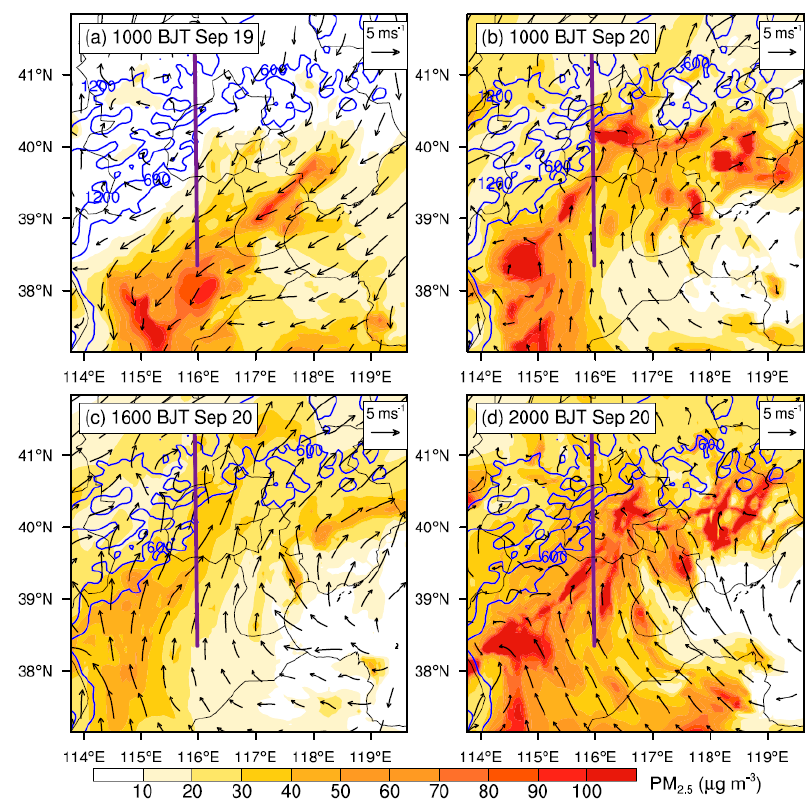
Figure 8. Spatial distributions of simulated near-surface PM 2.5 concentration at ( a ) 10:00 h BJT on 19 September, and ( b – d ) 10:00, 16:00, and 20:00 h BJT on 20 September, overlaid with 10-m wind vector fields. The blue contour lines show the map of terrain height (m AMSL), and the violet line across Beijing from south to north denotes the locations of vertical cross sections shown in Figures 9, 11, and S4.